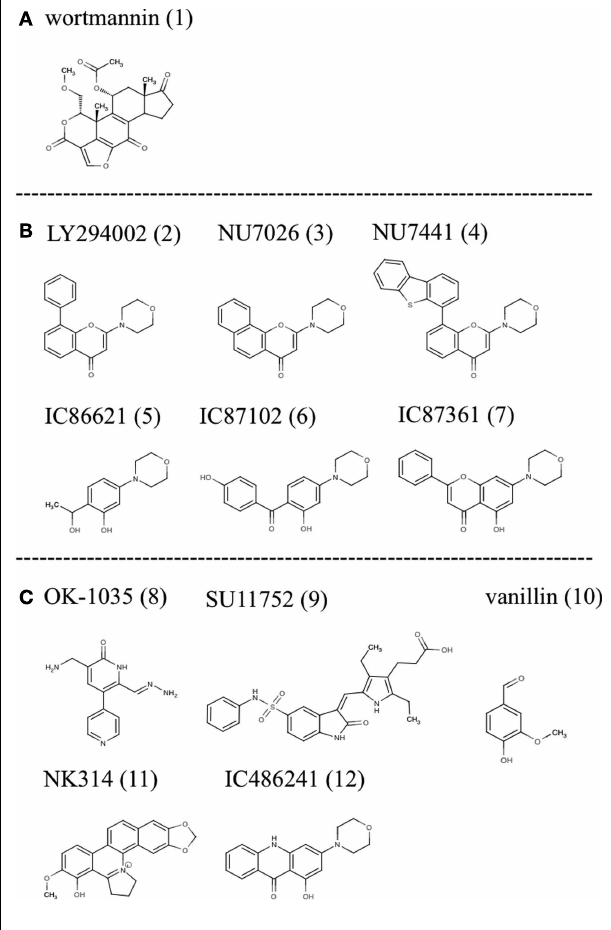
FIGURE 1 | Small molecule inhibitors of DNA-PK: (A) wortmannin, (B) LY294002 derivatives, and (C) other molecules with demonstrated inhibitory